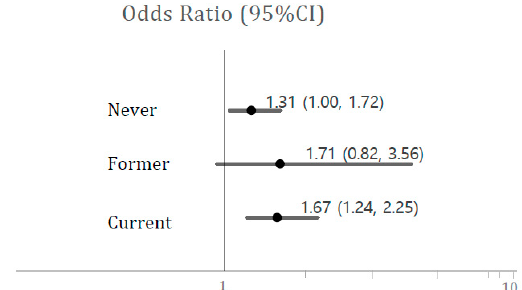
Figure 3. Odds ratios (95% CIs) of hypertension associated with high BCd level by smoking status. BCd levels were defined as follows: High BCd: > 1.874 µ g / L (90th percentile of BCd level). Associations between high BCd level and risks of stroke, IHD, and hypertension. Table 3. Odds ratios (95% CIs) of cardiovascular diseases associated with high BCd level a . Total ( n =